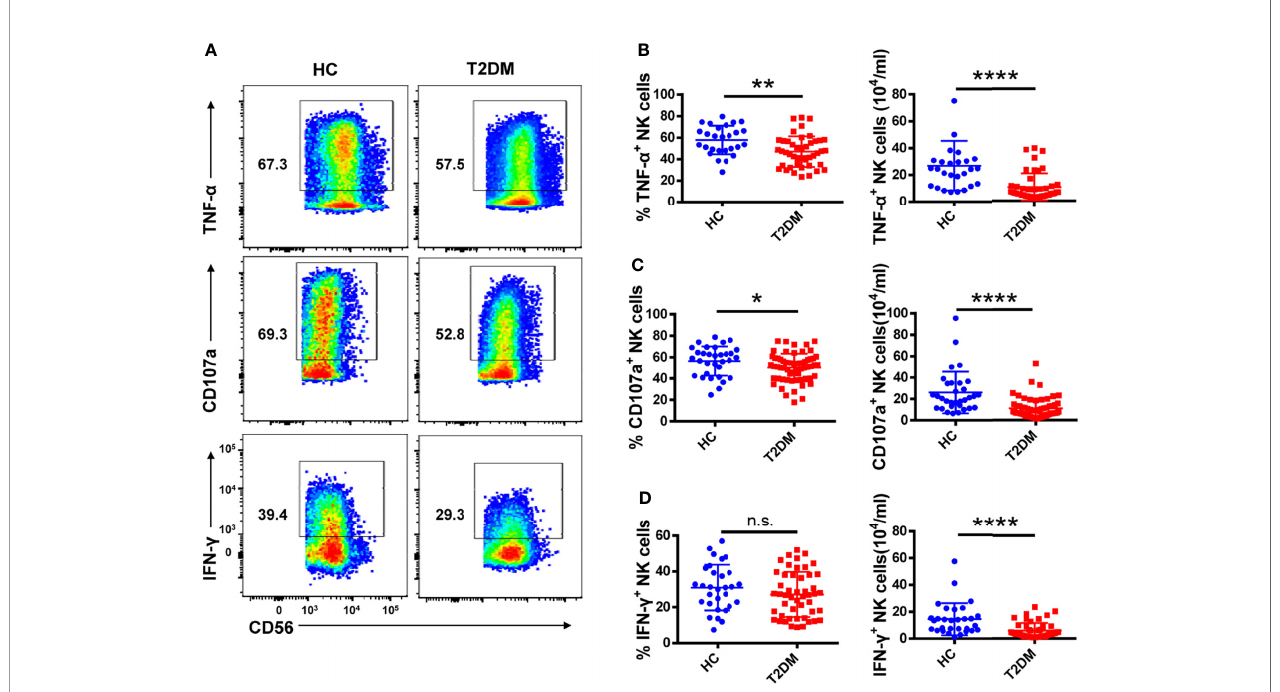
FIGURE 3 | Circulating NK cells from patients with T2DM show functional impairment. (A) PBMCs from T2DM and healthy controls (HC) were stimulated with PMA and ionomycin and the expression of TNF- a , IFN- g , and CD107a by NK cells was determined by fl ow cytometry. (B – D) Analysis of the percentage and absolute number of TNF- a + (B) , CD107a + (C) , and IFN- g + (D) NK cells in patients with T2DM and HC. Each dot represents a different individual and results are presented as the mean ± SEM; *p < 0.05, **p < 0.01, ****p < 0.0001, n.s., not signi fi